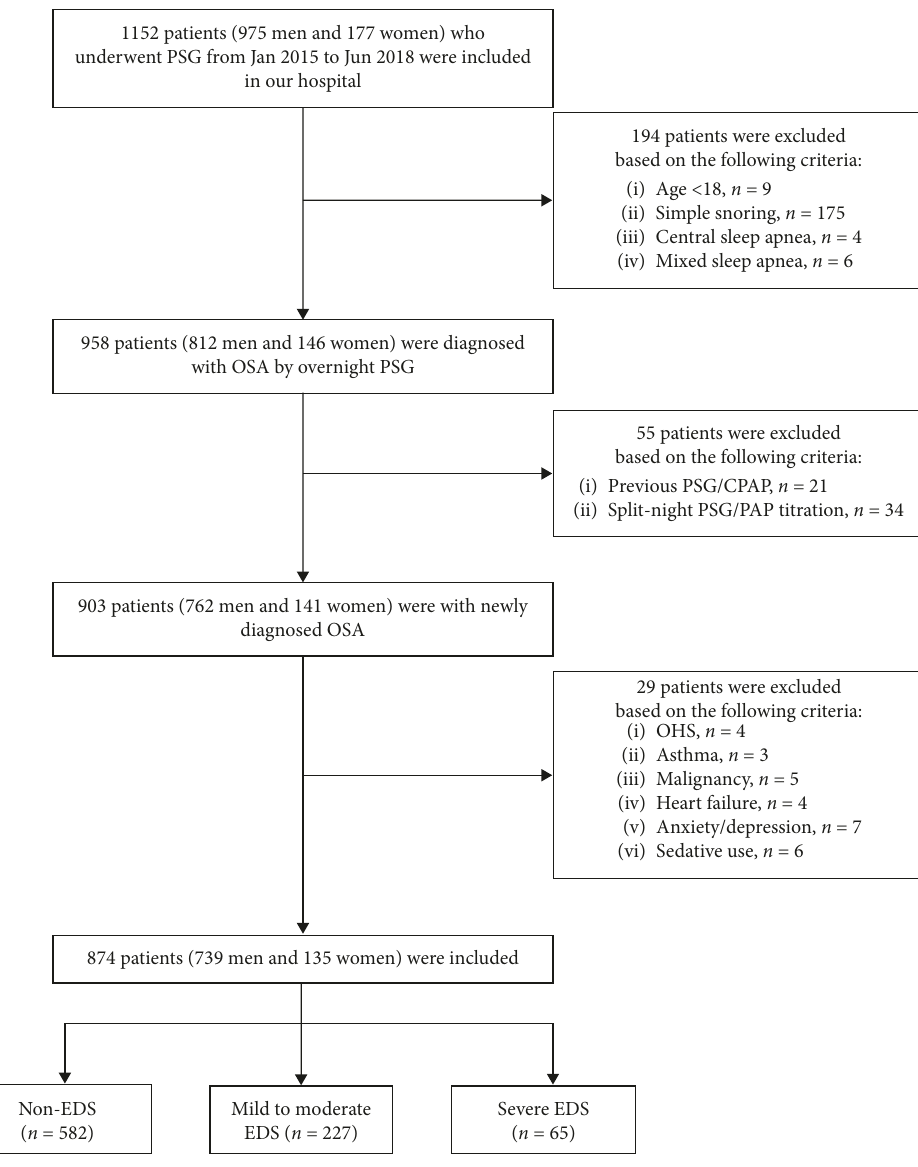
Figure 1: Flow chart of the patients’ inclusion process. PSG: polysomnography; OSA: obstructive sleep apnea; CPAP: continuous positive airway pressure; PAP: positive airway pressure; OHS: obesity hypoventilation syndrome; EDS: excessive daytime